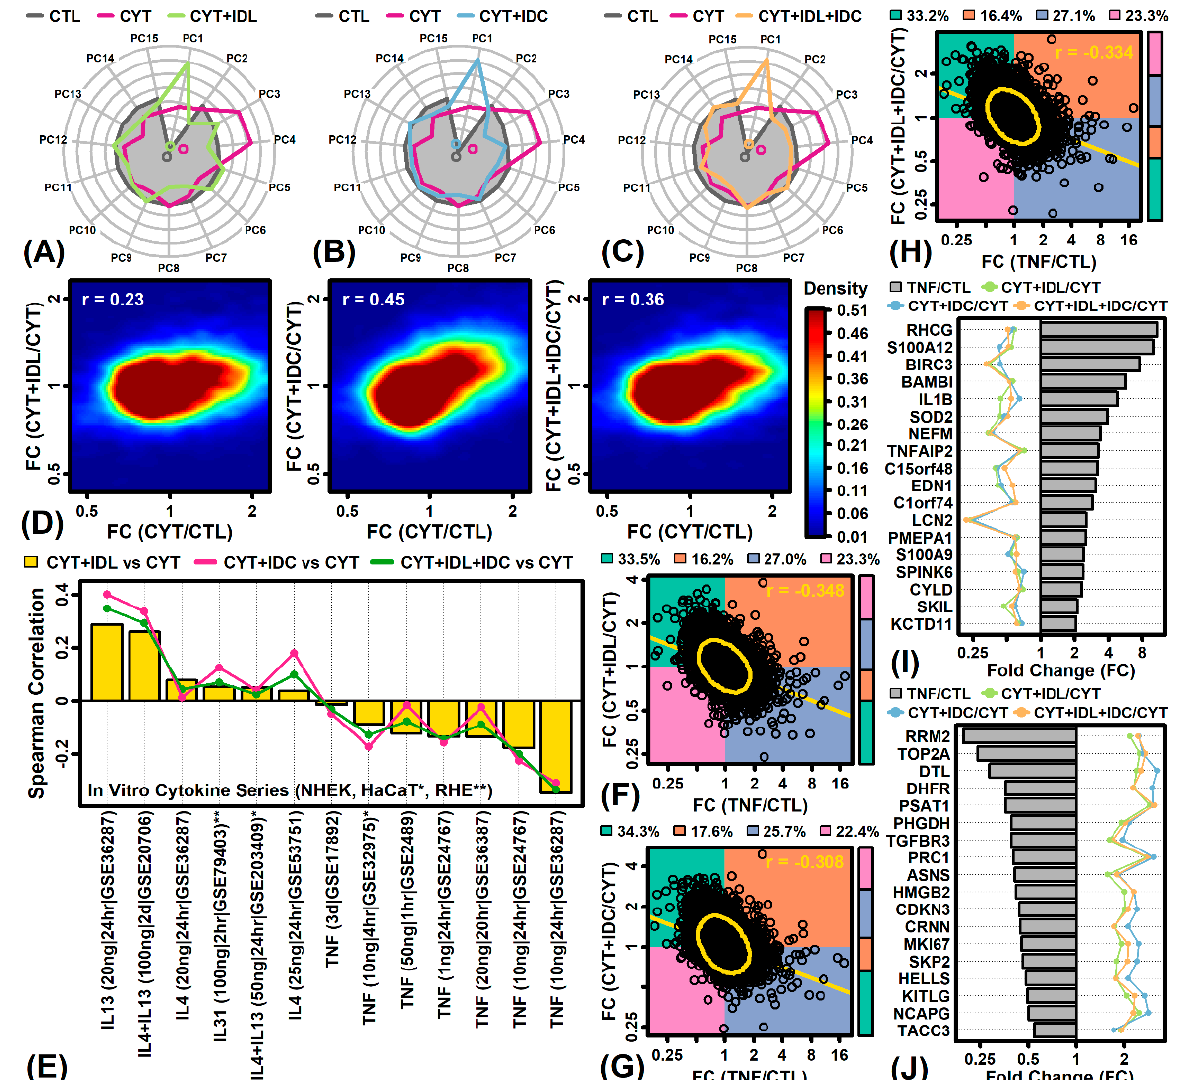
Figure 4. Comparison to Th2 and TNF- α cytokine responses. ( A – C ) PC radial plots. Average PC scores are plotted for CTL and CYT samples along with those for each experimental treatment (CYT + IDL, CYT + IDC, CYT + IDL + IDC). ( D ) Gene density scatterplots. Scatterplots compare FC estimates between treatment and cytokine responses. ( E ) In vitro Th2 and TNF- α cytokine series. Fold-change estimates were compared to those observed in experiments in which normal human epidermal keratinocytes (NHEKs), HaCaT (*), or RHE (**) were treated with cytokines. The spearman correlation between FC estimates is shown for each comparison. The cytokine dose, treatment duration, and GEO accession number is given ( bottom margin ). ( F – H ) Scatterplot comparisons to TNF responses (GSE36287). Each point represents an individual gene. The proportion of genes within each quadrant is indicated ( top margin ) and represented by the sidebar. The spearman rank correlation is shown ( top right ). The yellow ellipse outlines the middle 90% of genes closest to the bivariate centroid (Mahalanobis distance). The least-squares regression line is shown (yellow). ( I ) TNF-increased genes down-regulated by experimental treatments. ( J ) TNF-decreased genes up-regulated by experimental treatments. In ( I , J ), each gene was increased or decreased significantly by treatment of primary human KCs with TNF (10 ng/mL) for 24 h (FDR < 0.10, GSE36287). FC estimates are shown for each experimental treatment (see top margin legend ).